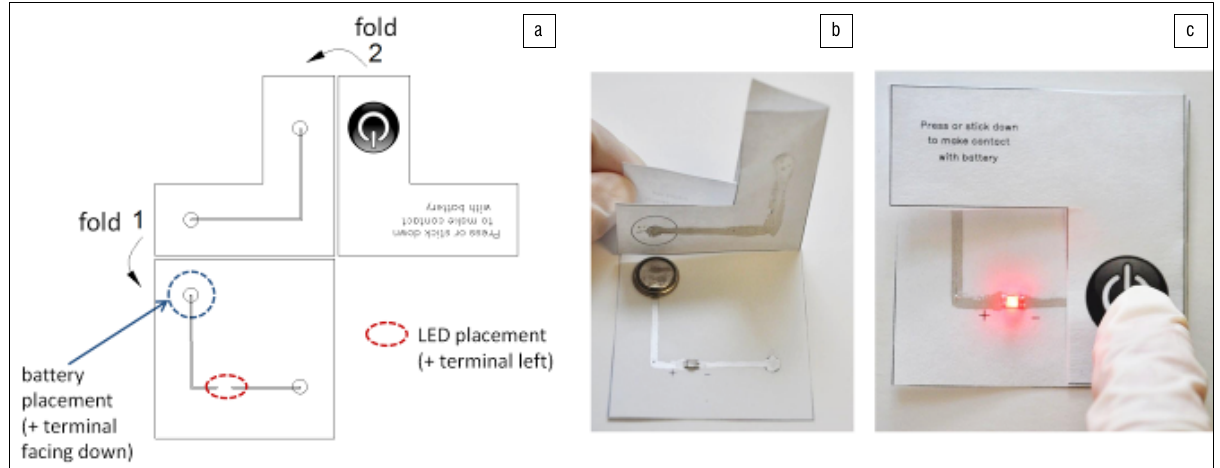
Figure 8: Manual manufacture of a simple paper-based electronic device on standard printing paper: (a) layout design of a manual button and LED power indicator. The three-layer design houses a battery and LED on the bottom layer, onto which the middle layer is folded (fold 1), followed by the folding of the top layer containing the paper button. (b) Device assembly and folding is illustrated, with electronic pathways painted in silver and electronic components mounted. (c) The complete functional device is illustrated; the LED illuminates when the paper button is pressed.